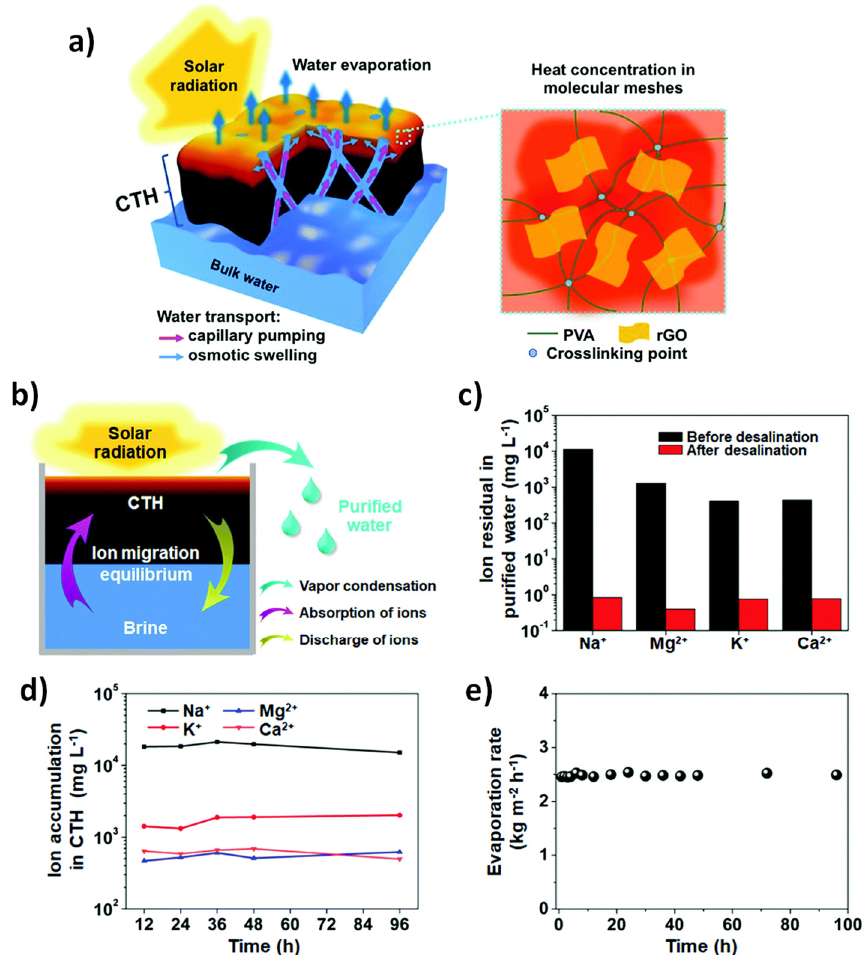
Figure 9. Hybrid hydrogel capillarity aided water transport for solar vapor generation: ( a ) powered by solar energy, intense water evaporation (blue arrows) occurs. Floating hydrogel transports water from the bulk to the evaporation surface, reducing water loss over evaporation. Reduced graphene oxide (rGO) absorbers harvest, transfer, and confine solar energy to the molecular mesh on the surface; ( b ) schematic representation of the solar desalination system; ( c ) concentration of the main ions in seawater before and after desalination; ( d ) concentration of the ions collected in the system over time; and ( e ) duration test of the system for 96 h based on constant solar desalination. Adapted with permission from [131]. Copyright © RSC Publishing